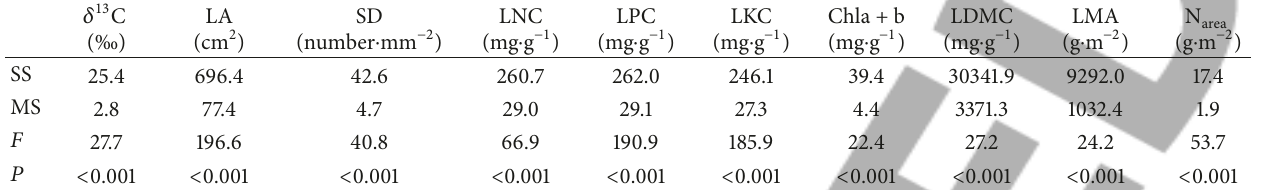
Table 2: Significance of the altitudinal effects on leaf